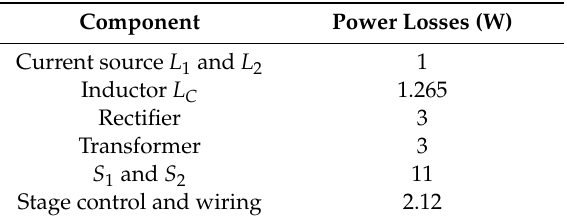
Table 8. Total power losses by applying GaN and SiC power devices.